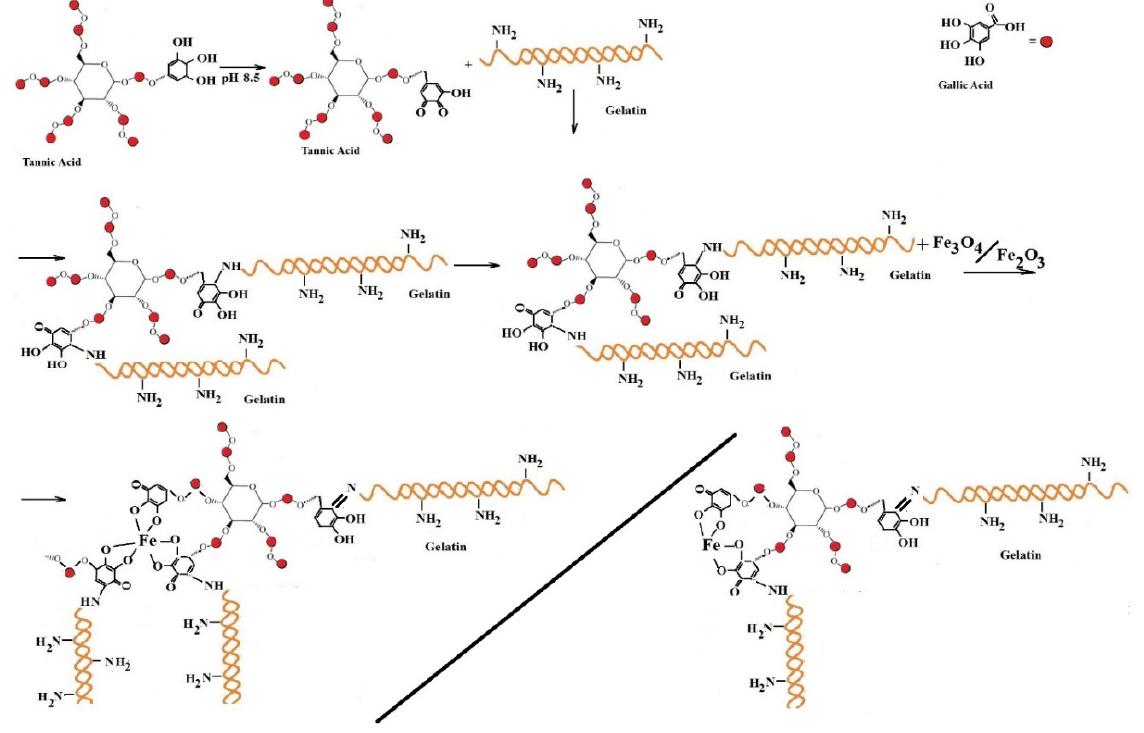
Figure 2. Illustration of possible interactions between tannic acid, gelatin, and iron oxide nanopar- ticles.